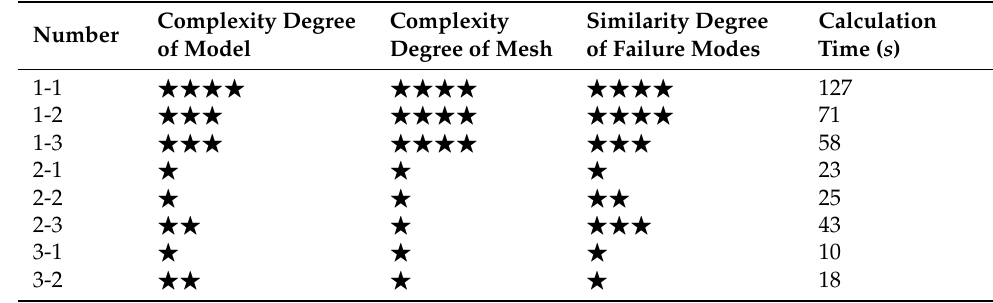
Table 8. Comparison of the simplified FEA